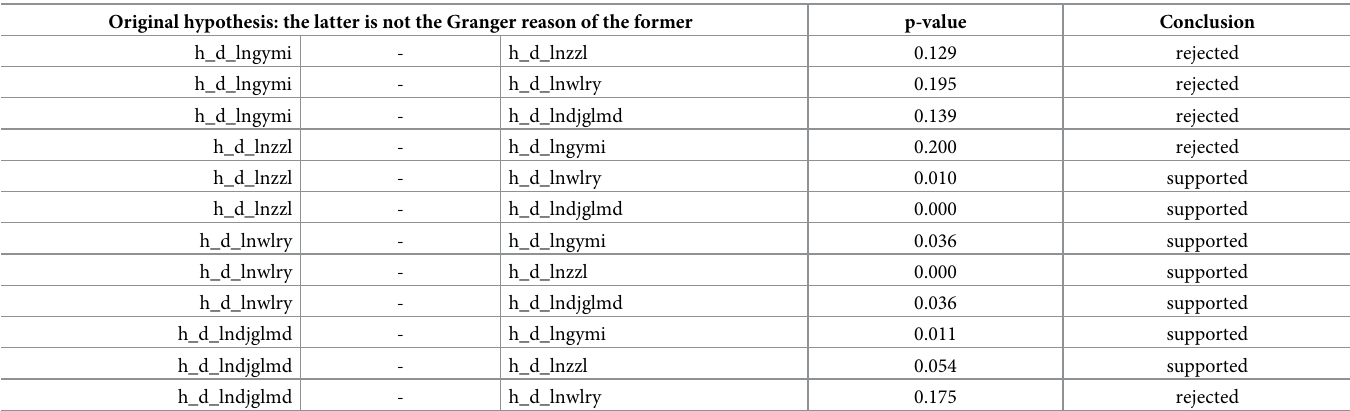
Table 16. Granger causality test of logistics industry and the manufacturing MI. Original hypothesis: the latter is not the Granger reason of the